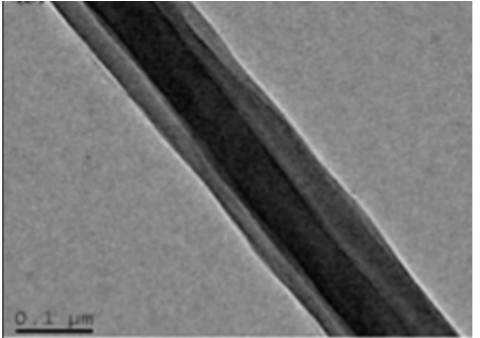
Figure 3. SEM micrograph of a core-shell electrospun fiber (adapted from [80], published by MDPI, 2019).